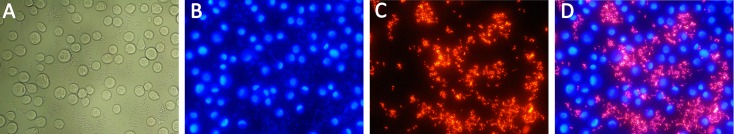
Fluorescence microscopy imaging of R2LC-mCherry adhering to IPEC-J2 cells.(A) Bright-field image. (B) Fluorescence imaging of the DAPI stained IPEC-J2 cells. (C) Fluorescence imaging of R2LC-mCherry. (D) Merging of the B and C images.